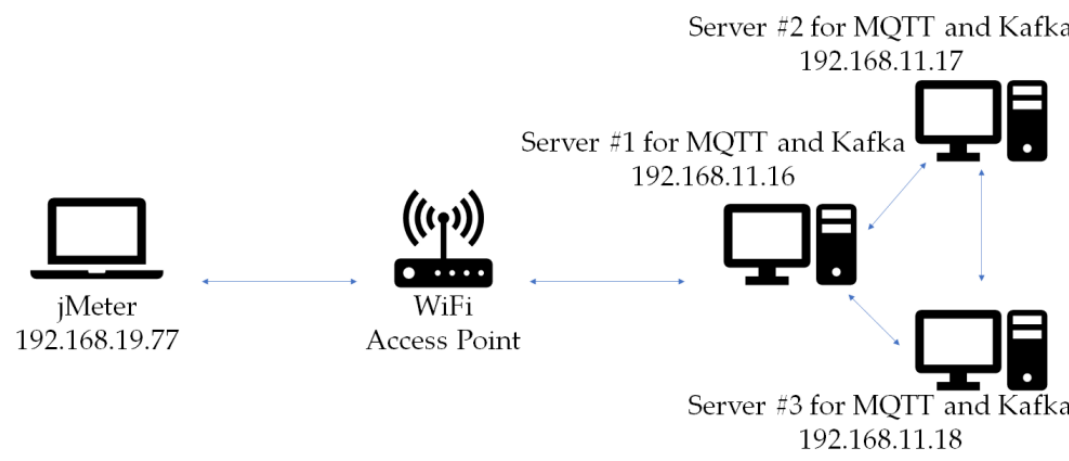
Figure 12. System architecture for evaluation.